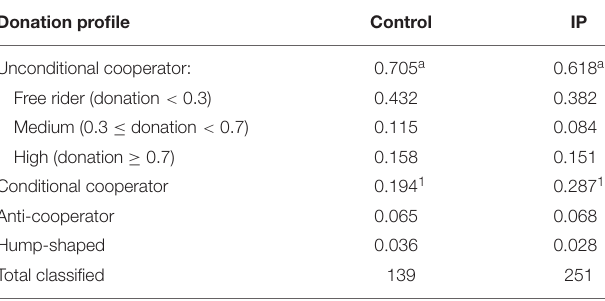
TABLE 8 | Conditional donation profiles by treatment, Study